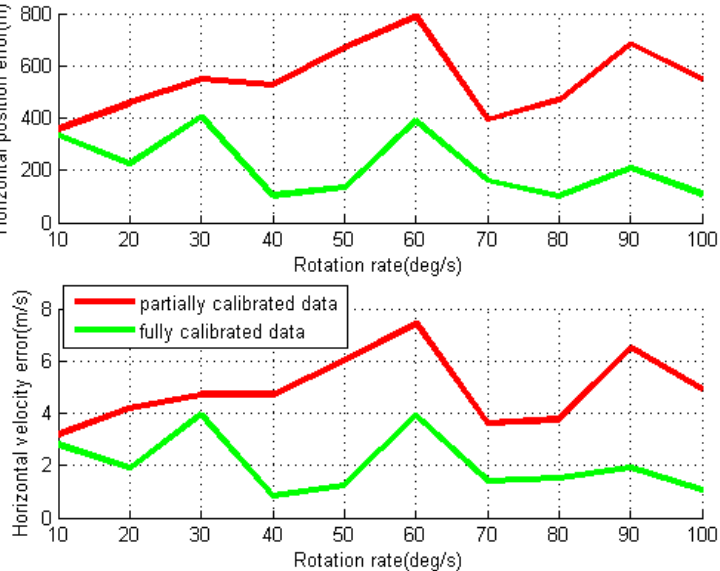
Figure 11. RMS values of horizontal position and velocity errors for rotary INS with different IMU rotation rates using NAV440.